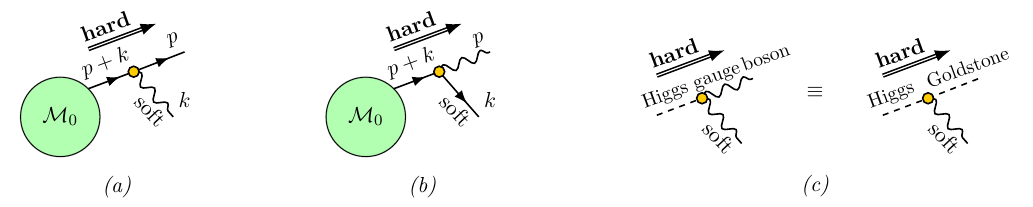
Figure 2 . Pictorial representation of eikonal (a) and non-eikonal (b) contributions to a photon emission amplitude. It is understood that k is soft and collinear with p , i.e. k = (cid:15)p with (cid:15) (cid:28) 1 . In the eikonal case spin is unchanged along the hard line. (c): a Higgs boson emits a soft gauge boson transforming into a gauge boson along the hard line. This is equivalent to a Higgs transforming into a Goldstone boson